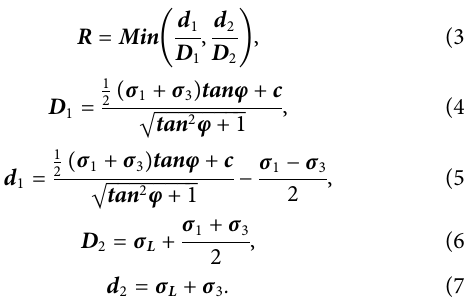
Frontiers in Earth Science |